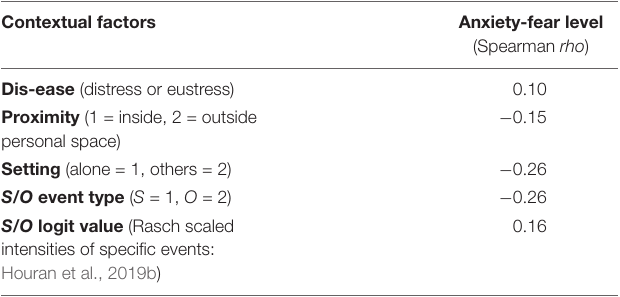
TABLE 7 | Primary percipient’s anxiety–fear levels during anomalous experiences correlated to situational factors. Contextual